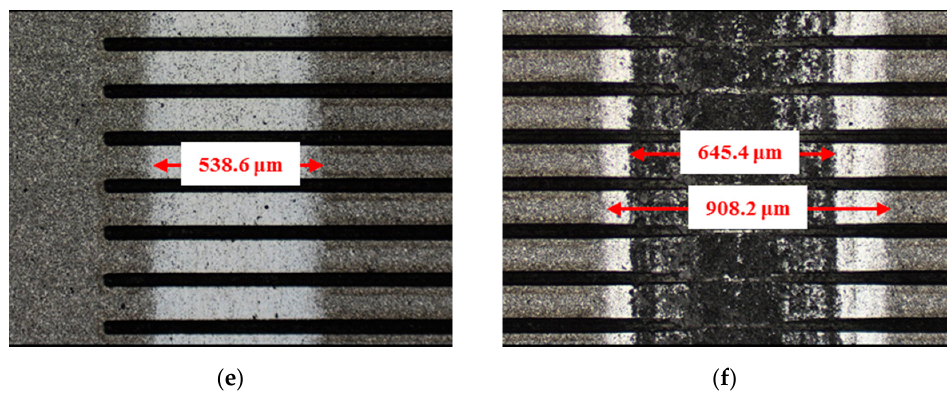
Figure 9. Wear performance of groove-textured SiC under dry-friction conditions with a load of 30 N (×10): ( a ) 3 μ m groove-textured SiC–steel ball, ( b ) 3 μ m groove-textured SiC–Si 3 N 4 ball, ( c ) 5 μ m groove-textured SiC–steel ball, ( d ) 5 μ m groove-textured SiC–Si 3 N 4 ball, ( e ) 10 µ m groove-textured